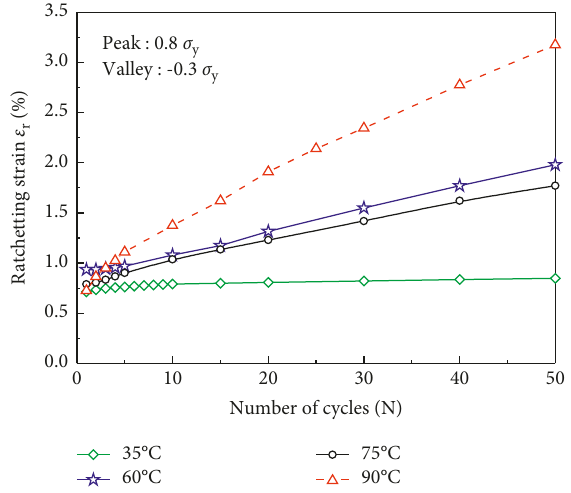
Figure 6: The evolution of multiaxial ratchetting strain of poly- carbonate with the number of cycles under the rhombic-type 1 loading path condition with a constant peak stress of 0.8 × σ y and a constant valley stress of − 0.3 × σ y at different